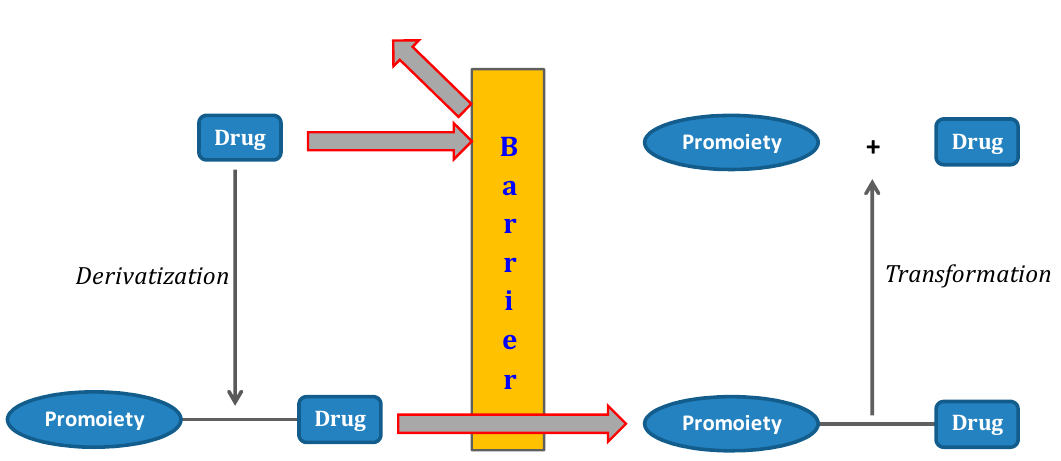
Figure 1. Illustration of prodrug concept. (Adapted from Ref. [5]).